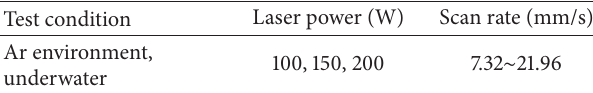
Table 1: Chemical compositions of AISI D2 steel. Element Fe Cr C Mo Mn V Si wt.% Table 2: Experimental conditions for the direct laser hardening.